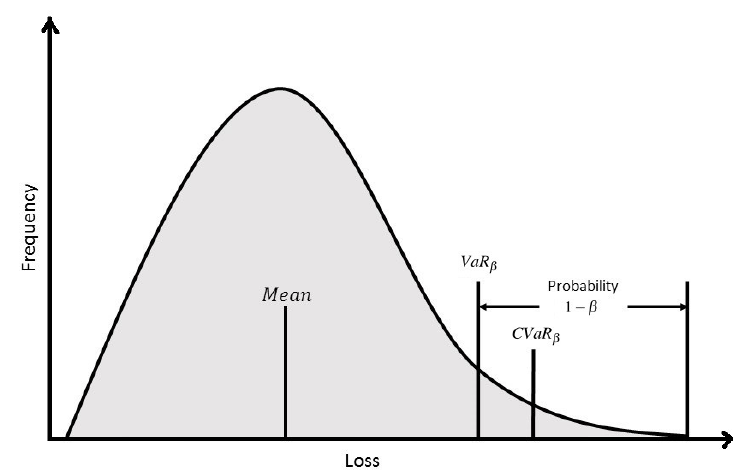
Figure 4. Depiction of the definition of Conditional Value at